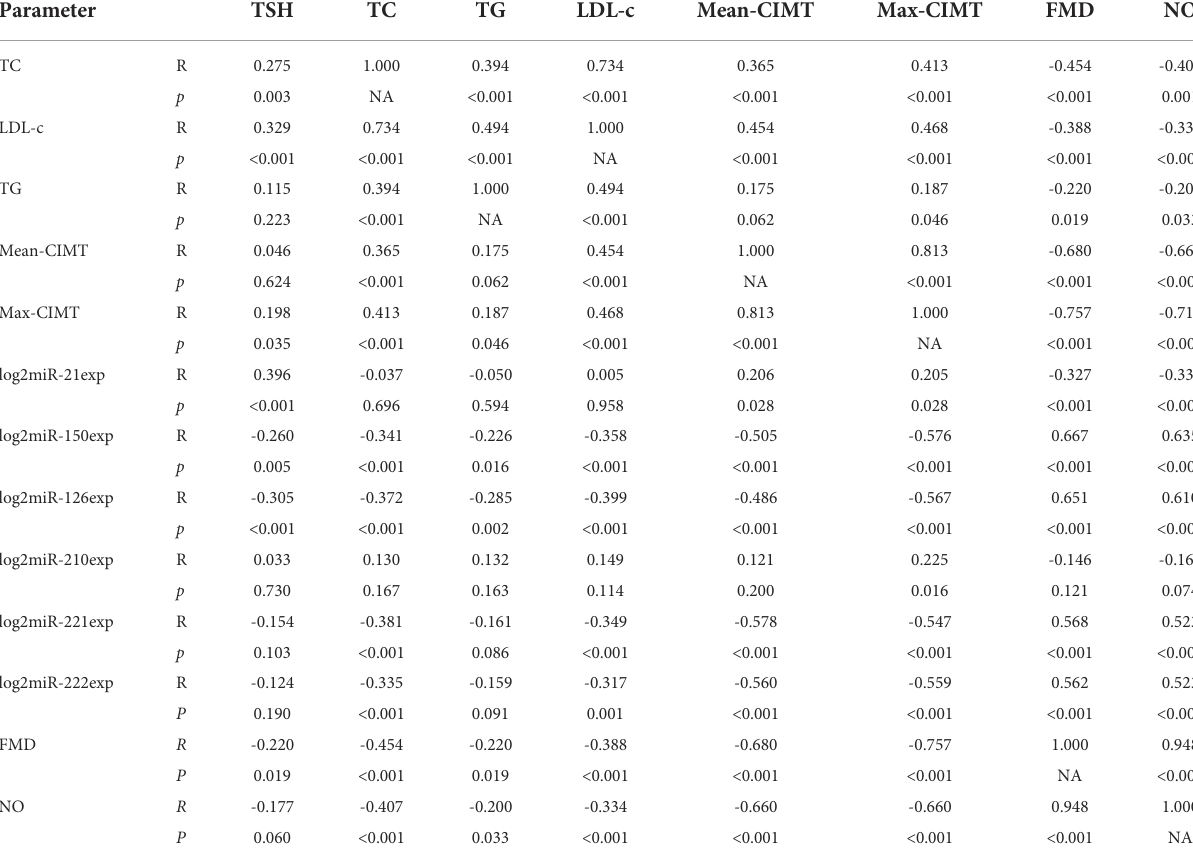
TABLE 2 Spearman ’ s Correlation Analysis of some parameters and Expression of Six MicroRNAs in All Subjects. Parameter